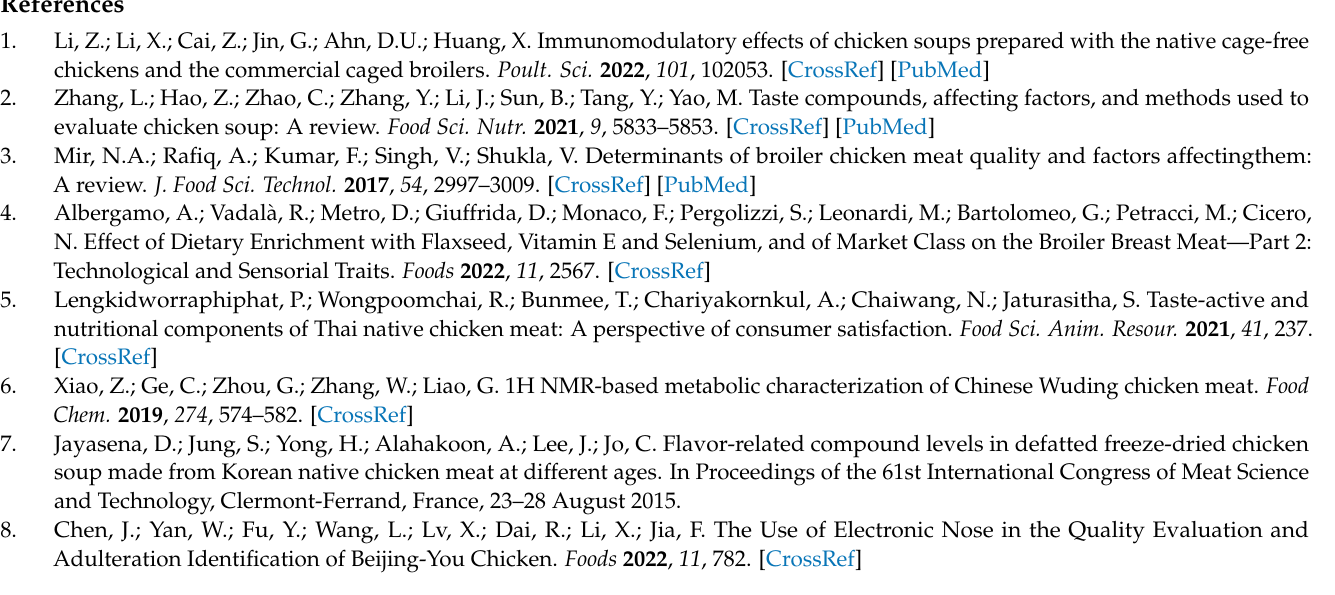
Table S1: Basic ingredients of four chicken breast samples; Table S2: Chemicals information; Table S3: Instrument conditions for LC-QTOF-MS/MS analysis; Table S4: Kruskal-Wallis test results for taste profiles of four chicken soup samples; Table S5: Compounds identified in four soup